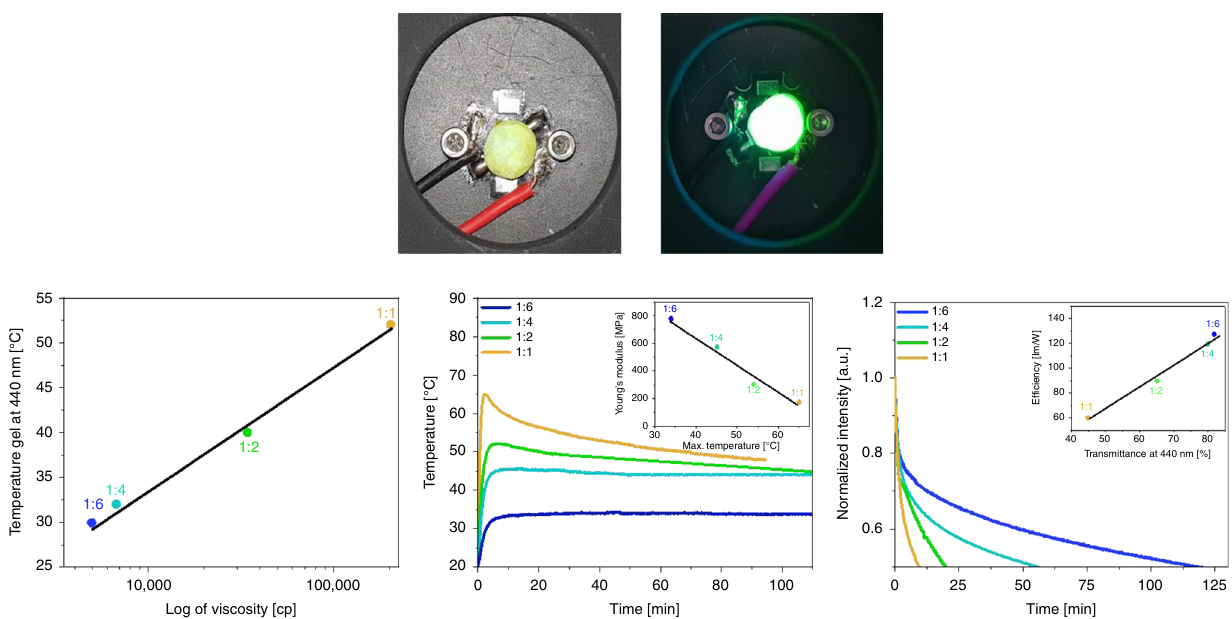
Fig. 4 Bio-HLED characterization. Top: pictures of Bio-HLEDs at work. Bottom: linear relationship ( R 2 = 0.99 for linear fi tting, solid black line) between heat generation and viscosity (left) of eGFP-AA doped TMPE:PMMA gels with different mass ratios. Increase in temperature (center) and emission intensity decay (right) over time in Bio-HLEDs operating at 200 mA for biophosphors consisting of eGFP-AA doped TMPE:PMMA fi lters with different mass ratios (see legend). The inset shows the linear relationship ( R 2 > 0.98 for linear fi ttings, solid black lines) between (i) maximum temperature of the devices and Young ’ s modulus of the biophosphors (center) and (ii) device ef fi ciency and transmittance of the fi lters